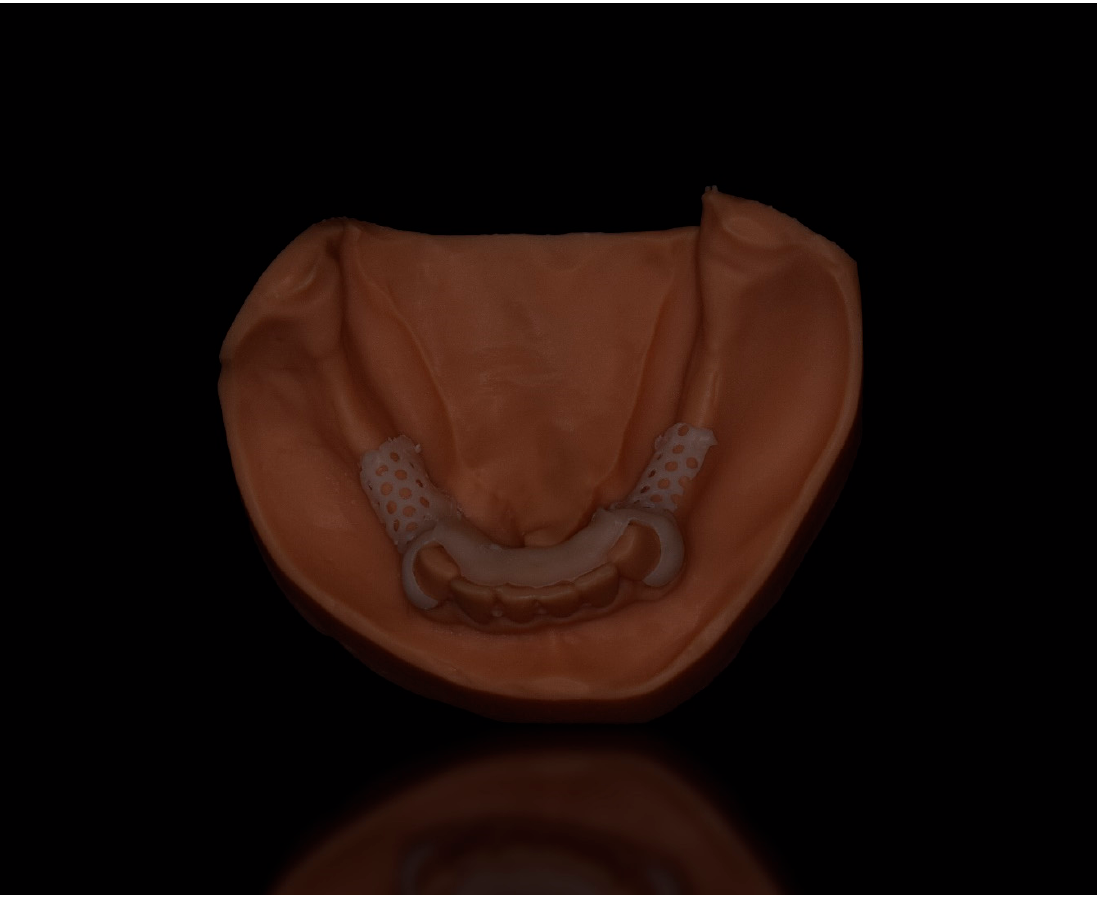
Figure 6. Although size and taper of clasp arms vary between materials and manufactures, coverage of the abutment teeth significantly increases with polymer-based